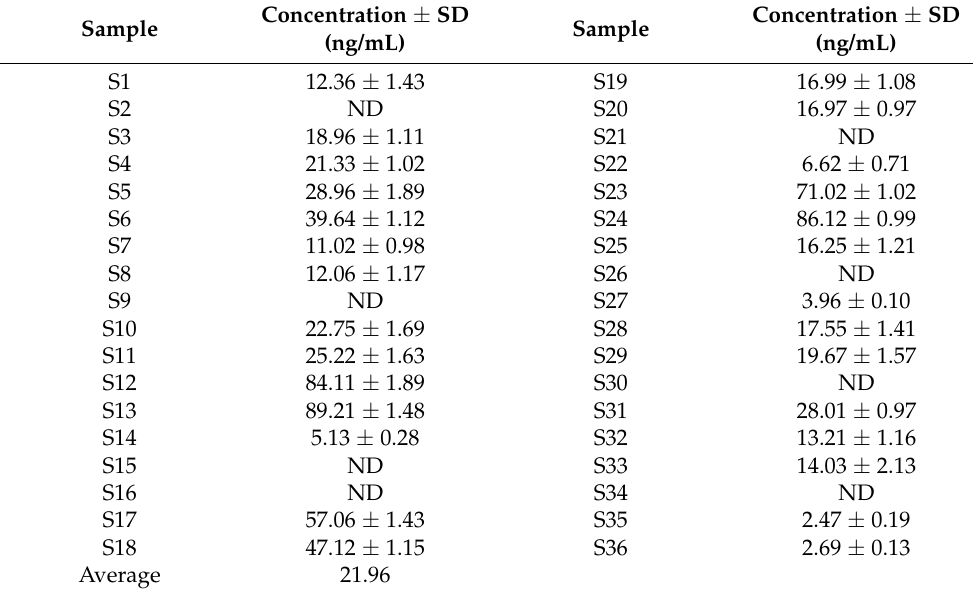
Table 3. The environmental levels of BBP in urban sewage samples.